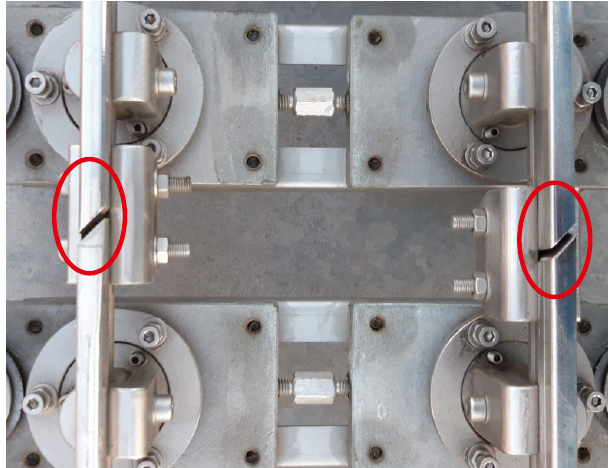
Figure 14. Largest gap between two consecutive rail sections of the